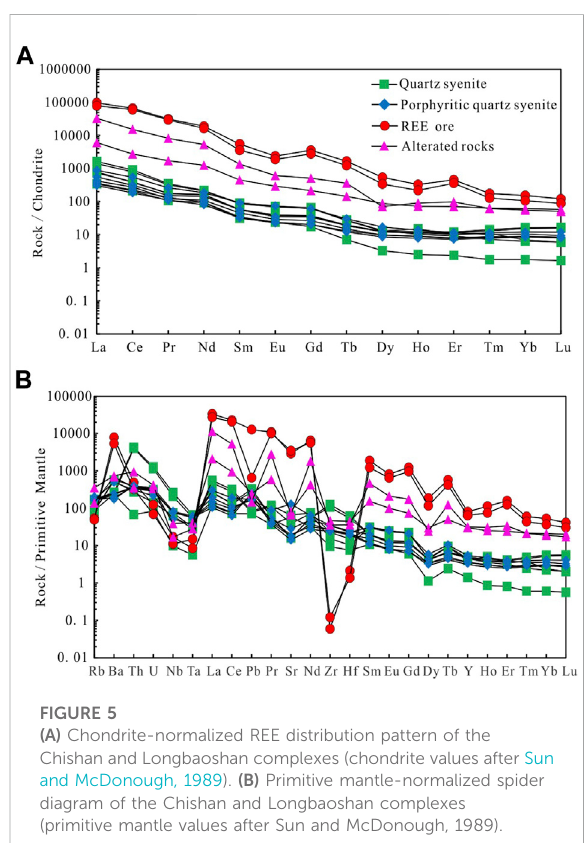
FIGURE 5 (A) Chondrite-normalized REE distribution pattern of the Chishan and Longbaoshan complexes (chondrite values after Sun and McDonough, 1989). (B) Primitive mantle-normalized spider diagram of the Chishan and Longbaoshan complexes (primitive mantle values after Sun and McDonough,